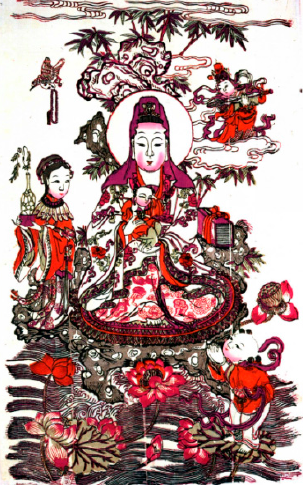
Figure 7. Print of Guanyin.